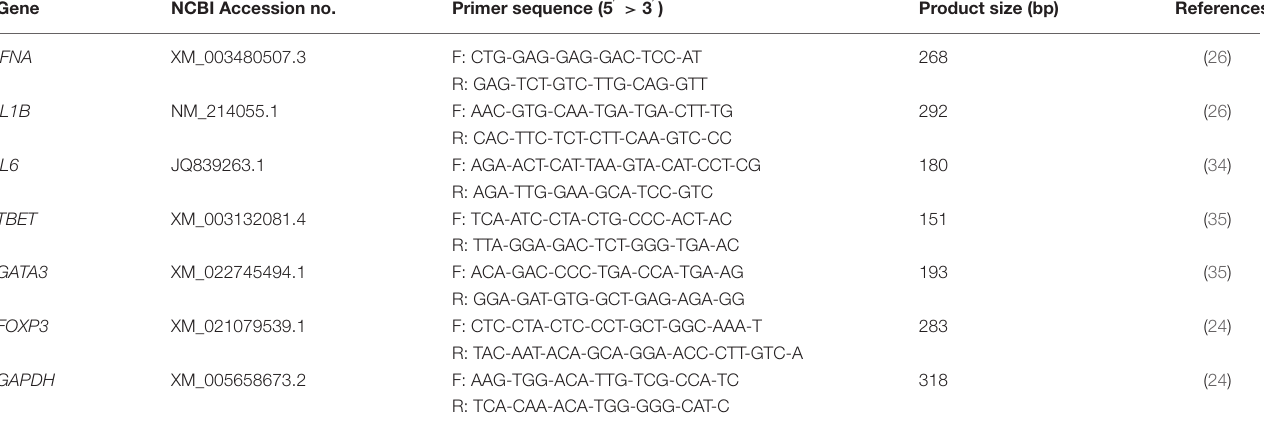
TABLE 1 | Sequences of the qPCR primers.